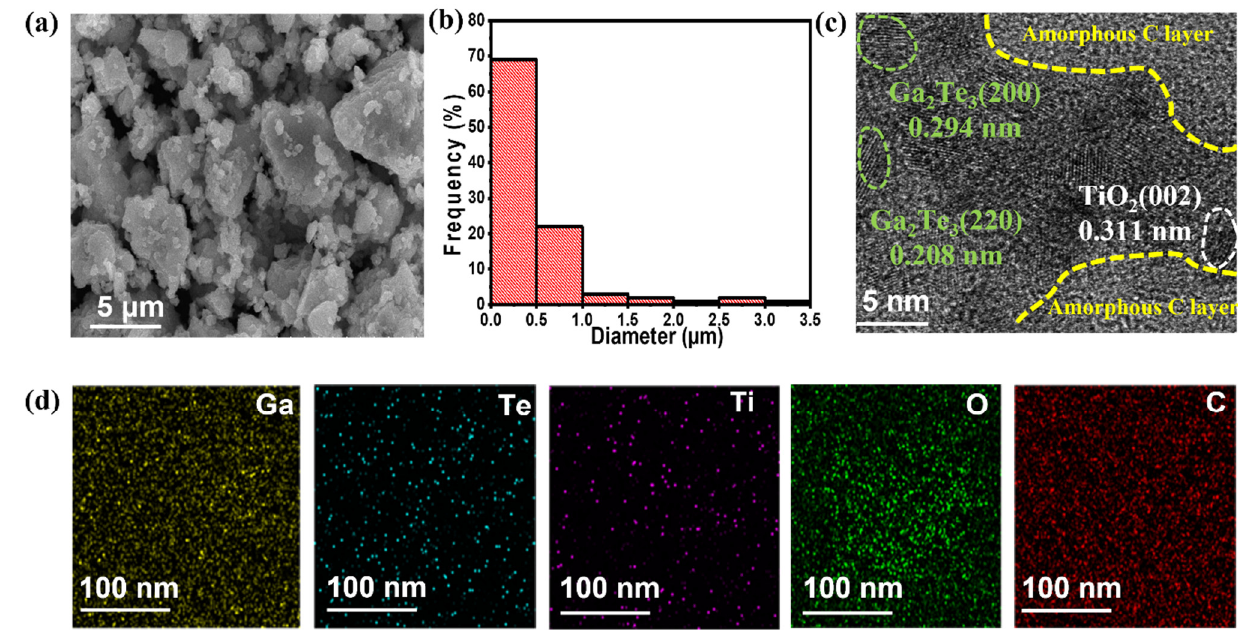
Figure 3. ( a ) SEM image; ( b ) particle size distribution; ( c ) HRTEM image and ( d ) EDXS elemental mappings of Ga, Te, Ti, O, and C for Ga 2 Te 3 -TiO 2 -C (10%). Ga 2 T 3 -TiO 2 -C with various C content for LIBs was investigated electrochemically us- ing half-cells electrode systems (Figure 4). The GCD voltage profiles of Ga 2 Te 3 -TiO 2 -C (10%), Ga 2 Te 3 -TiO 2 -C (20%), and Ga 2 Te 3 -TiO 2 -C (30%) are shown in Figures 4a and S8. The first discharge/charge performance of Ga 2 Te 3 -TiO 2 -C (10%), Ga 2 Te 3 -TiO 2 -C (20%), and Ga 2 Te 3 -TiO 2 -C (30%) were 892/677, 837/586, and 789/568 mAh g − 1 , respectively, which cor- responded to initial Coulombic efficiencies (ICEs) of 75.9%, 70.0%, and 71.9%, respec- tively. The three electrodes experienced irreversible capacity losses in the initial cycle that were attributed to the development of a solid electrolyte interfacial (SEI) layer. On the basis of the EDXS results (Figure S4) and the computed theoretical capacities of the sepa- rate elements (Table S1), the capacity contributions of C and TiO 2 to Ga 2 Te 3 -TiO 2 -C (10%) were estimated to be ~9% and ~16%, respectively. Therefore, active Ga 2 Te 3 (75% of the total capacity) was the principal source of the capacity of the electrode. The primary role of C and TiO 2 was as a buffering matrix (25% capacity involvement), which reduced the volume variation of the active material. Furthermore, the theoretical capacity contribution of different components in Ga 2 Te 3 -TiO 2 -C (20 and 30%) was also determined (Tables S2 and S3). Compared with Ga 2 Te 3 -TiO 2 -C (10%), increase in the C concentration results in a decrease in the capacity contribution of active material. Based on Figures S4–S6 and Tables S1–S3, the calculated capacity contribution of the active material Ga 2 Te 3 was 75, 61, and 53%, resulting in the actual Ga 2 Te 3 capacity of ~576, ~401, and ~314 mAh g − 1 for the Ga 2 Te 3 - TiO 2 -C (10%), Ga 2 Te 3 -TiO 2 -C (20%), and Ga 2 Te 3 -TiO 2 -C (30%), respectively. Notably, the measured capacities of Ga 2 Te 3 -TiO 2 -C (10%) and Ga 2 Te 3 -TiO 2 (455 and 477 mAh g − 1 , re- spectively, as computed in Table S4) that were higher than their theoretical capacities are most likely ascribed to the interfacial Li-ion storage and electrolyte decomposition. The specific performance of the lowest C content electrode (Ga 2 Te 3 -TiO 2 -C (10%)) was the highest in terms of stability and capacity. It reached 768.9 mAh g − 1 with capacity retention (CR) of 99.8% after 300 cycles at 100 mA g − 1 (Figure 4b). The specific capacities of Ga 2 Te 3 - TiO 2 -C (20%) and Ga 2 Te 3 -TiO 2 -C (30%) were 587.3 and 585.3 mAh g − 1 after 300 cycles at 100 mA g − 1 , respectively, which corresponded to a CR of 89.2% and 98.7%, respectively. This behavior was further explained using Coulombic efficiency (CE, Table S5) and dif- ferential capacity plot (DCP) analyses of the first 300 cycles (Figure S9). The CE increased